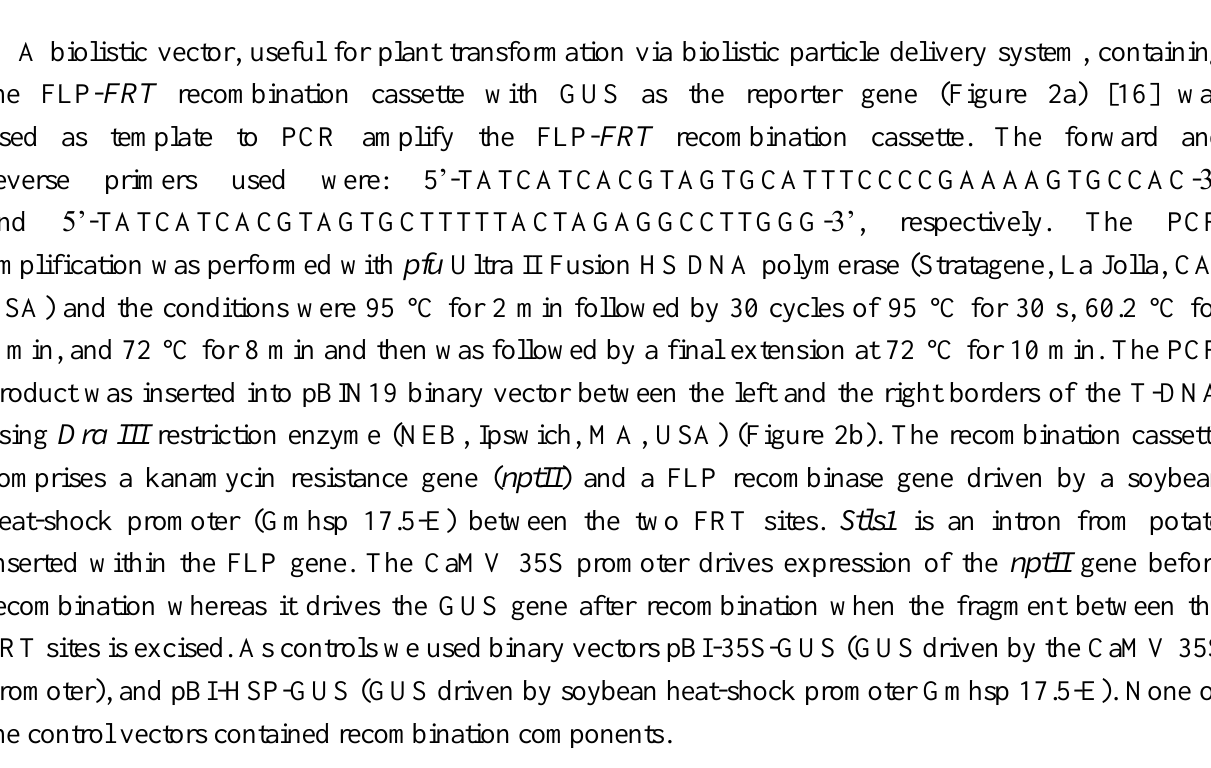
Figure 2. Schematic diagram of the biolistic and binary vectors. (a) The source plasmid of the recombination cassette. (b) Region between the left border (LB) and right border (RB) in the binary vector pBIN-HSP-FLP-GUS-Hyg containing the recombination cassette. 35S—CaMV 35S promoter, FRT—FLP recombination target, NptII—kanamycin DNA recombinase, Stls1—intron from potato, OCS—octopine synthase terminator, GUS—  -glucuronidase, NOS—nopaline synthase